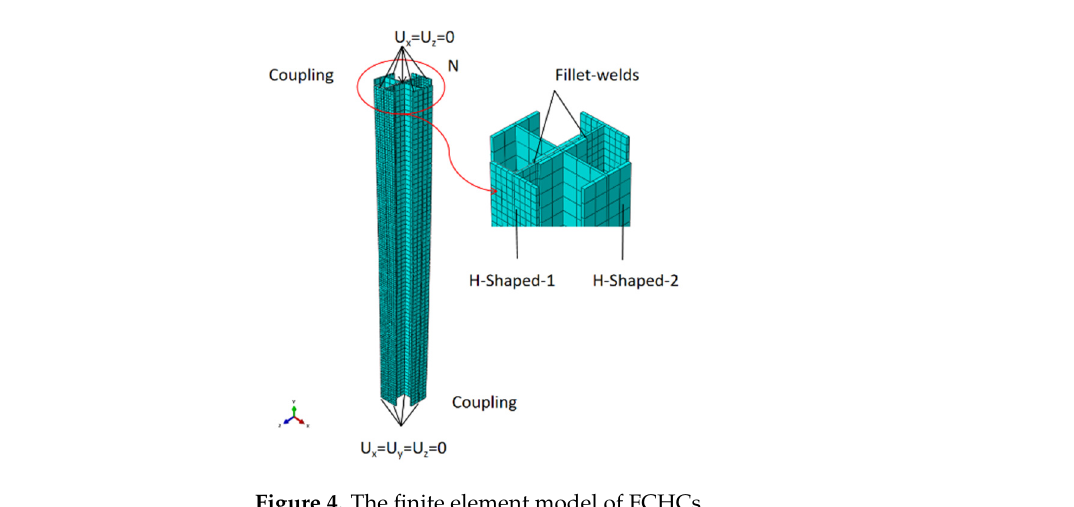
Table 1. Material properties of Q345 steel used in ABQUAS.